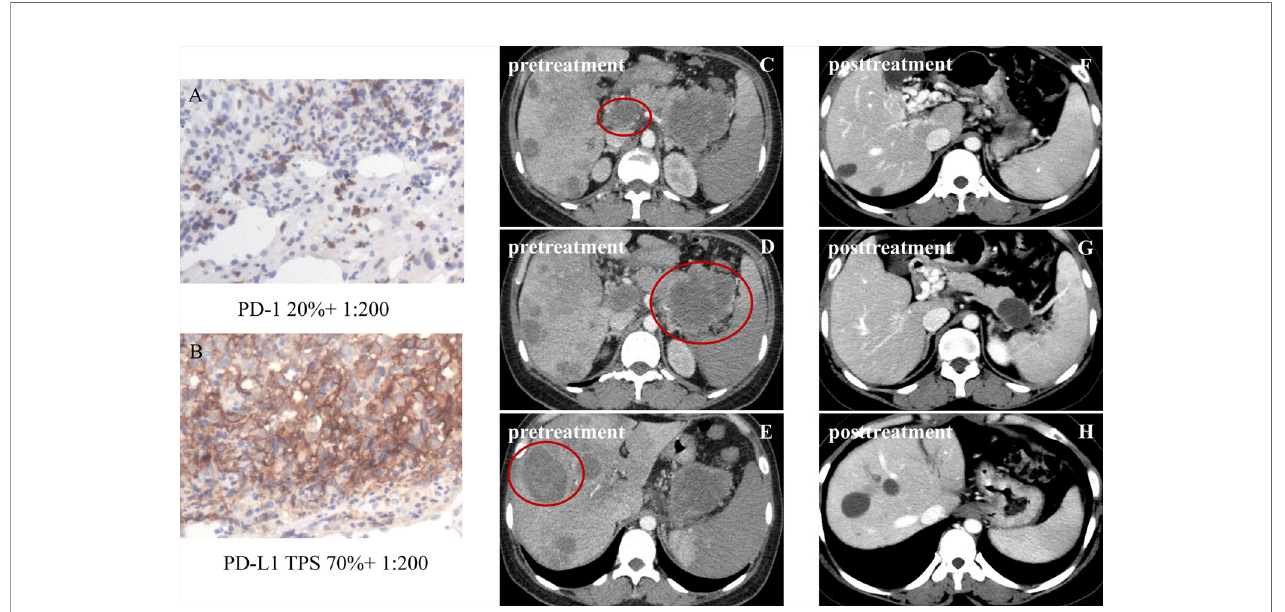
FIGURE 5 | Partial response in a patient with metastatic intrahepatic cholangiocarcinoma (iCCA), after four cycles of sintilimab plus lenvatinib. The tumor was de fi ned as PD-1 20% and PD-L1 TPS 70% (A, B) ; pretreatment fi gures are depicted in panels (C – E) , of metastatic iCCA with lymph node metastasis and pancreatic metastasis; post-treatment fi gures of metastatic ICC are depicted in panels (F – H) . The sizes of the liver tumors, the retroperitoneal lymph node, and the metastatic pancreas obviously shrank, and some liver tumors disappeared. Until now, no disease progression had been